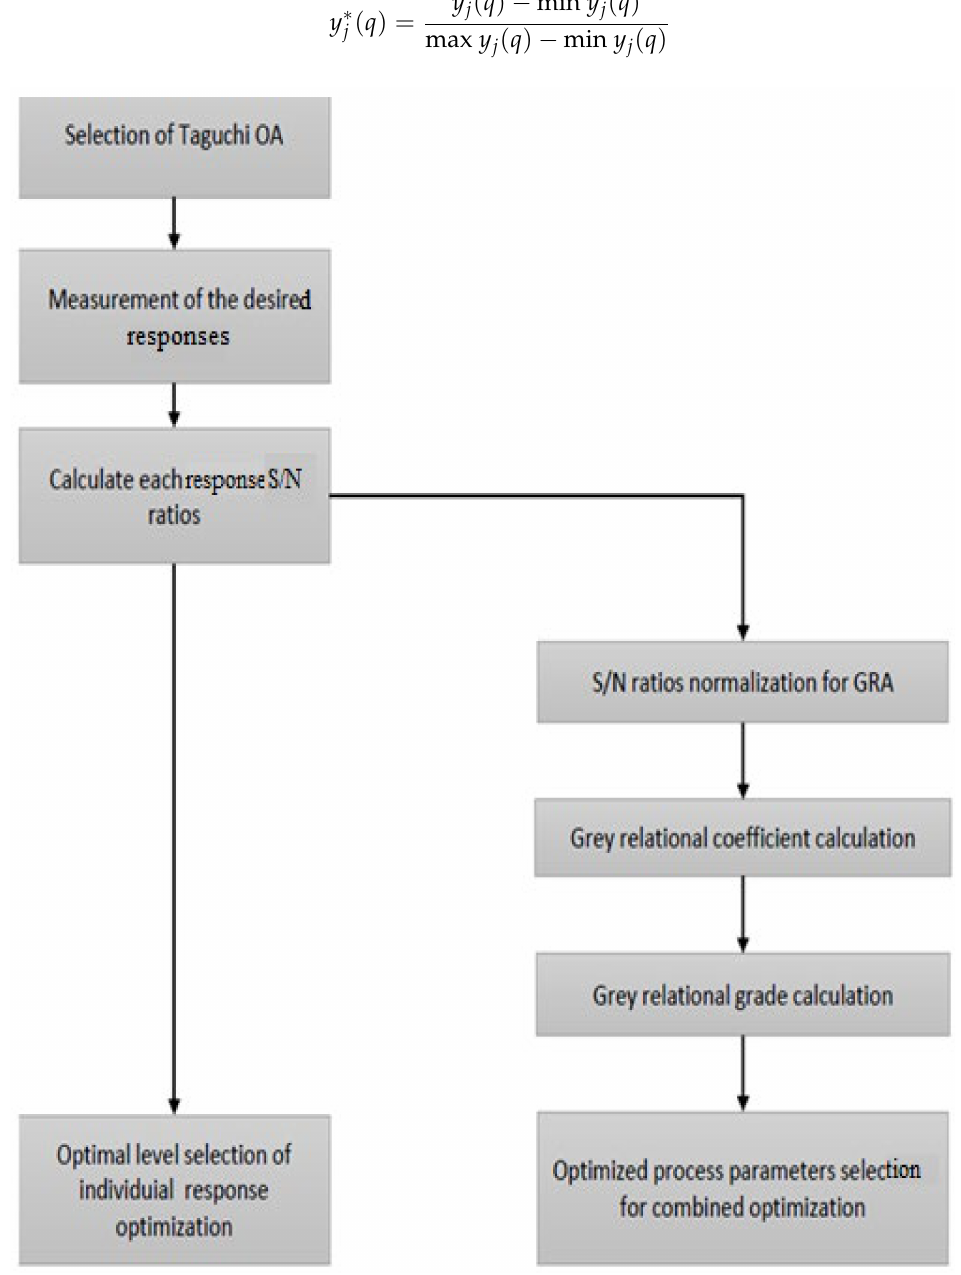
Figure 14. Concept of GRA-PCA.